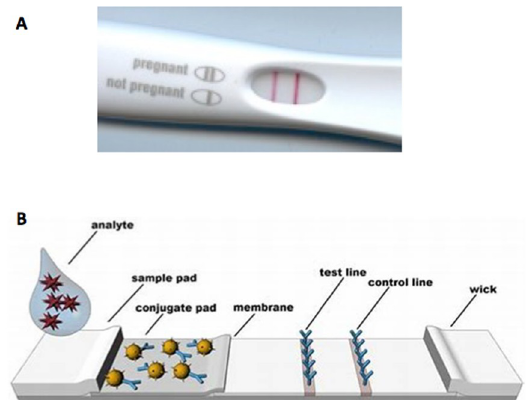
Figure 1. ( a ) Pregnancy test and ( b ) structure of a lateral flow assay. From Miočević, O. et al. [25] . Figure 1. ( A ) Pregnancy test and ( B ) structure of a lateral flow assay. From Mioˇcevi´c, O. et al.